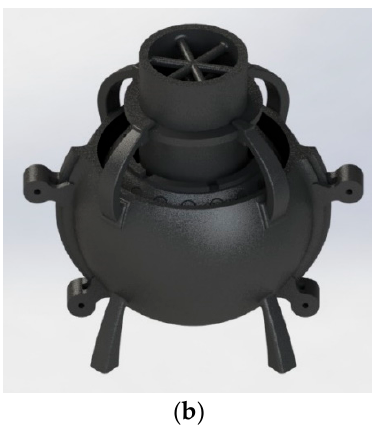
Table 2. Normalized x , y , z coordinates and polarity of rotor PMs.